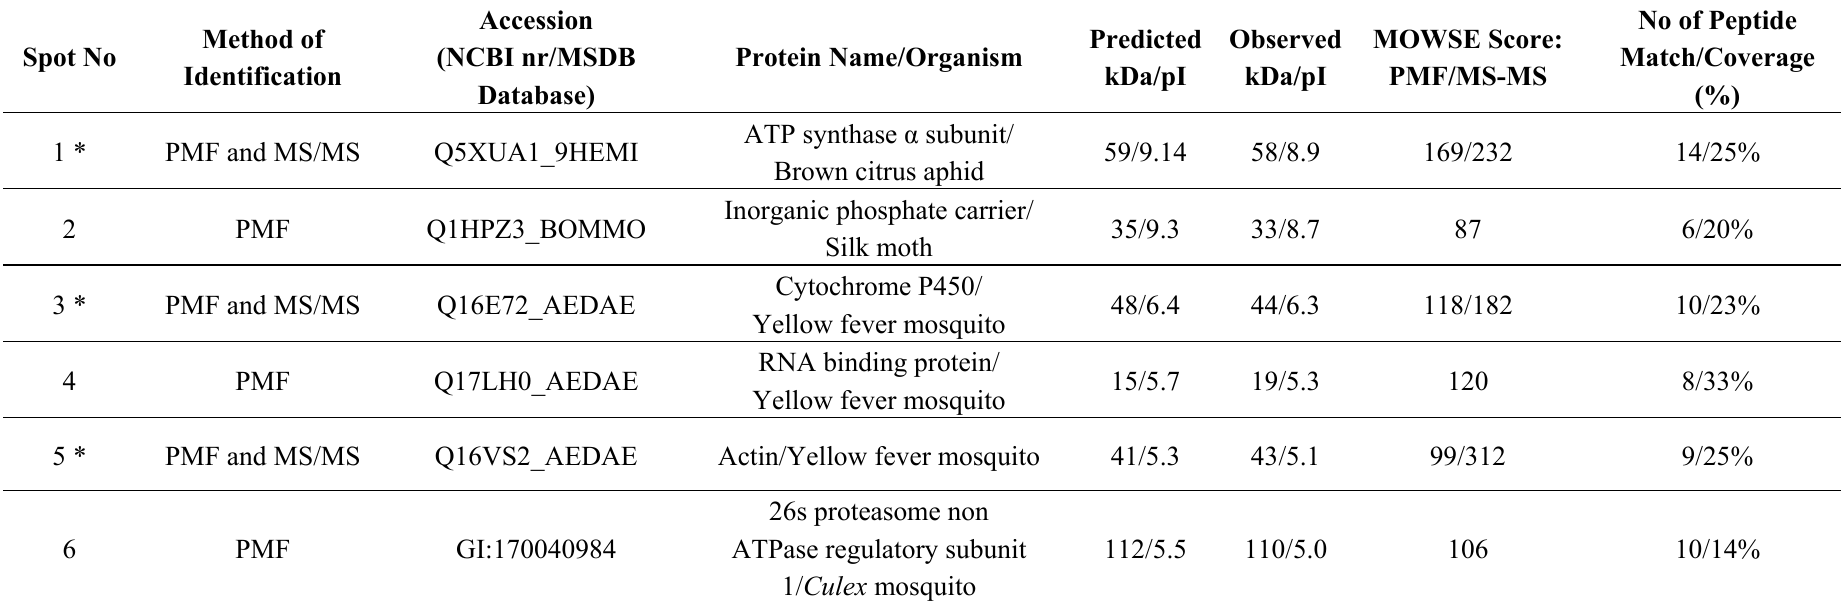
Table 1. Potential binding partners of CEA identified from MALDI-TOF MS and MS/MS